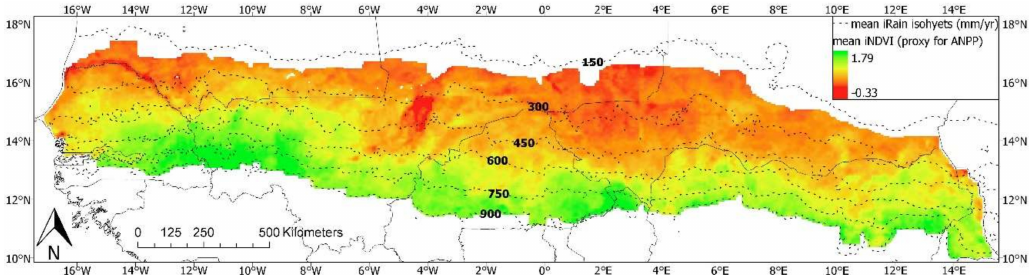
Figure 2. Summary of bioclimatic data used in the study: cumulative wet season normalized difference vegetation index (NDVI) ( i NDVI—used as an index of aboveground net primary productivity) and annual wet season rainfall integral ( i Rain). Values displayed are means for 32 years (1982–2013). See Supplementary Materials for links to Google Earth Engine codes used to prepare time series